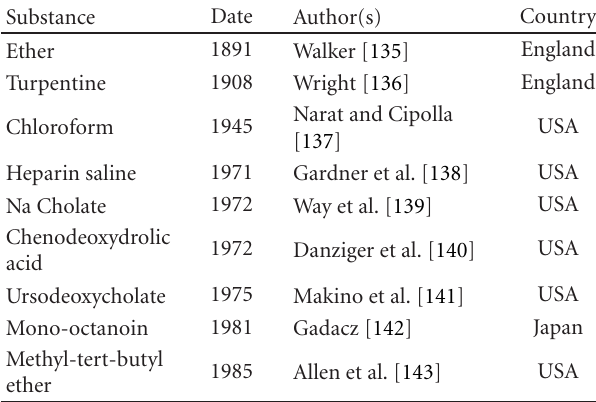
Table 3: Types of dissolving solutions for the treatment of CBDS